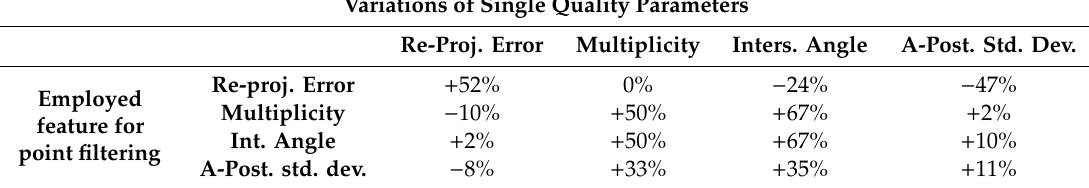
Table 2. Improvements (+) and worsening ( − ) of median values of the considered quality feature when only one feature is used to filter the 3D tie points. Variations of Single Quality Parameters Re-proj. Error Multiplicity